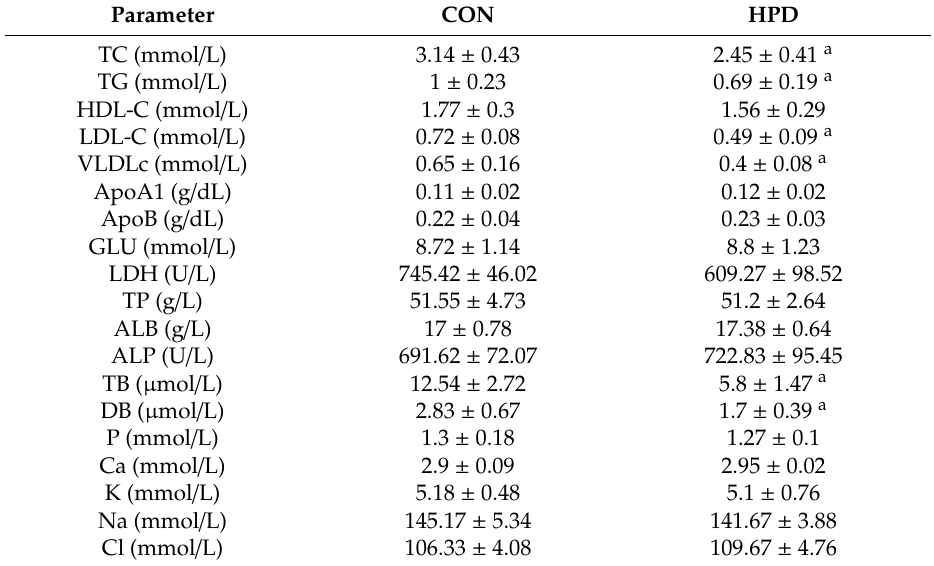
Table 2. Biochemical parameters in the first experiment chicken model of hyperuricemia.